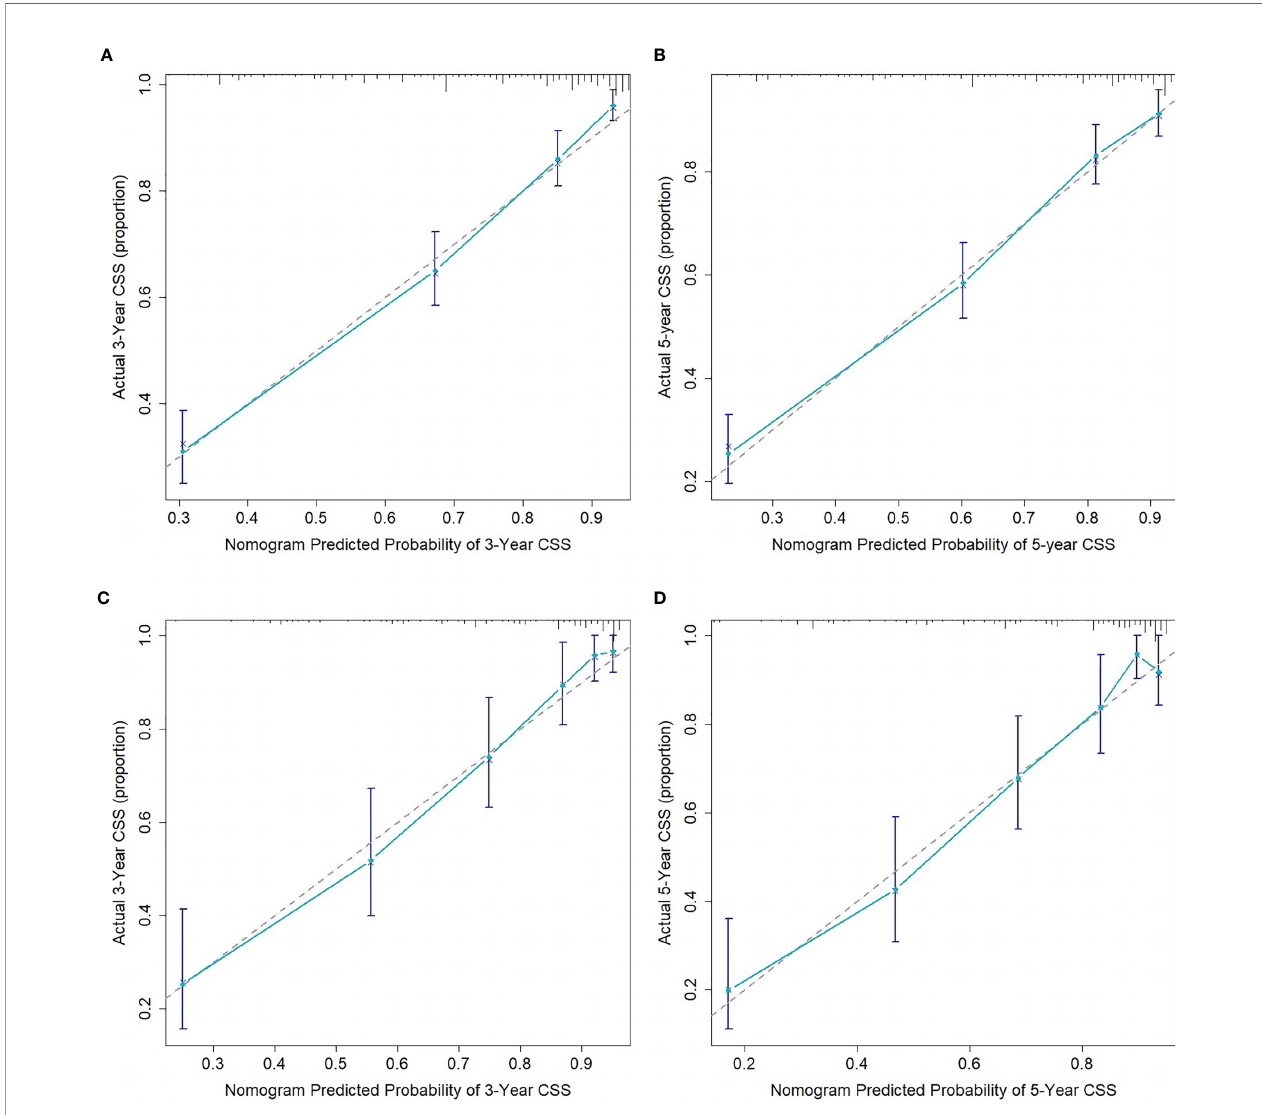
FIGURE 3 | Calibration curves for 3- (A) and 5-year (B) CSS of ASCC patients in the training cohort; Calibration curves for 3- (C) and 5-year (D) CSS of ASCC patients in the validation